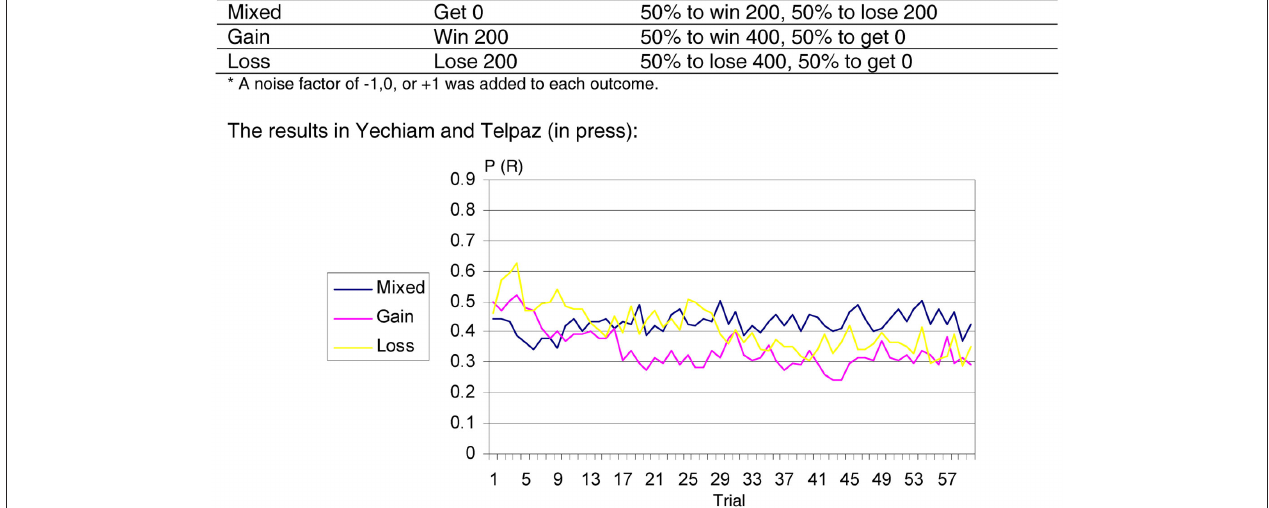
Figure 1 | risk taking in two studies of experience-based decisions. Top: Ert and Yechiam (2010). Bottom: Yechiam and Telpaz (in press). Each task involves the selection among a Safe option (S) and a Risky option (R). The results show